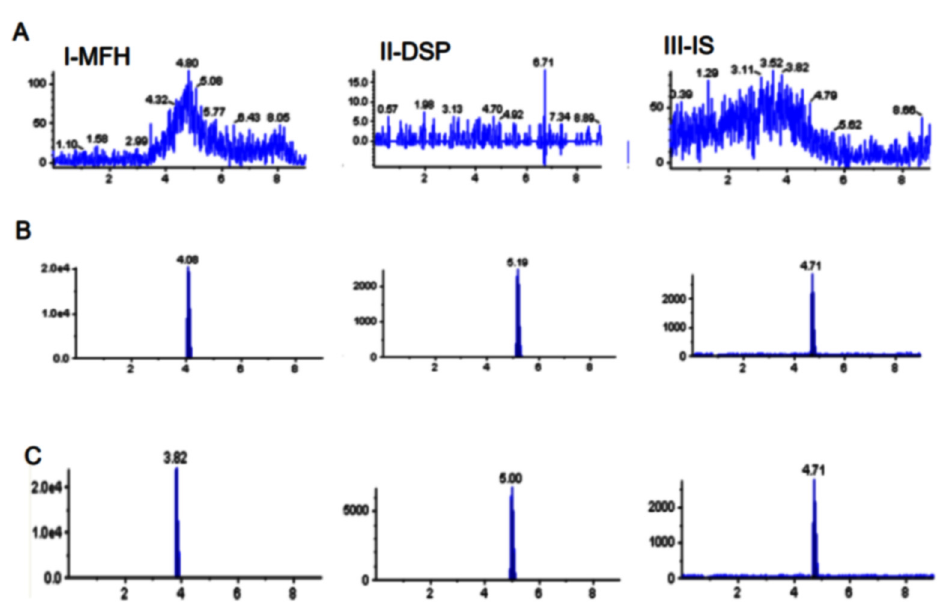
Figure 3. Typical MRM chromatograms of cornea treated with MFH ( A-I ), DSP ( A-II ), and IS ( A-III ) as well as blank cornea spiked with STD6 concentrations of MFH ( B-I ), DSP ( B-II ), and IS ( B-III ). The results of the pharmacokinetic study sample at 10 min are shown in panel C: MFH ( C-I ), DSP ( C-II ), and IS ( C-III ).